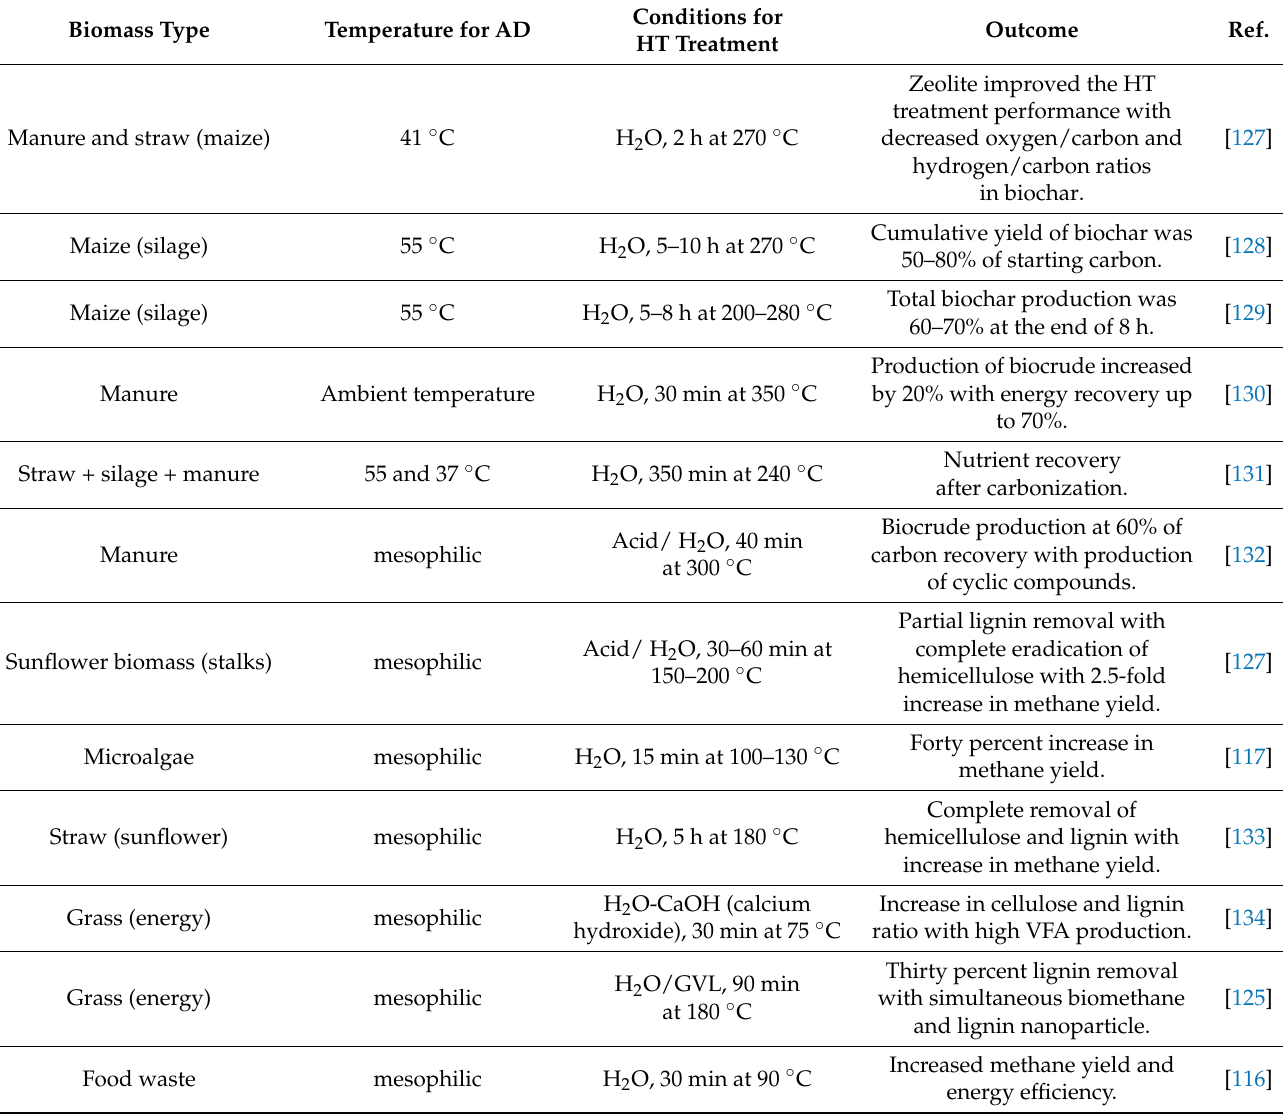
Table 3. Combinatorial HT treatment and AD for biomass